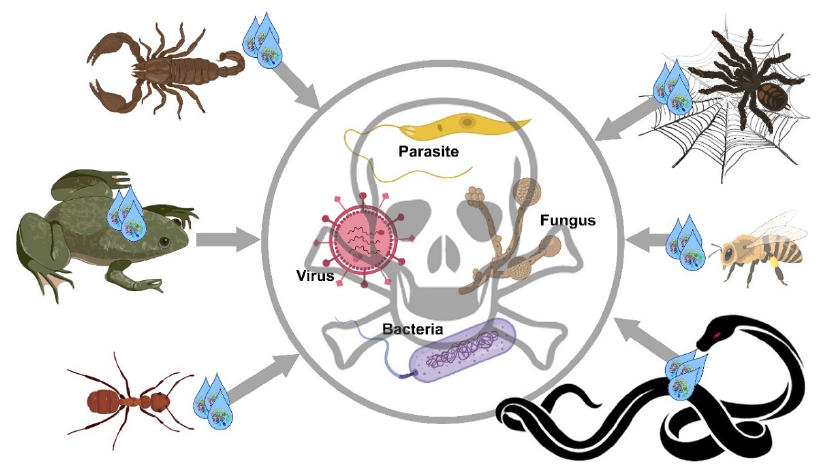
Figure 1. Schematic representation of the main animal venoms/secretions presented in this review for their antimicrobial properties, including antiparasitic, antiviral, antibacterial, and antifungal activities.